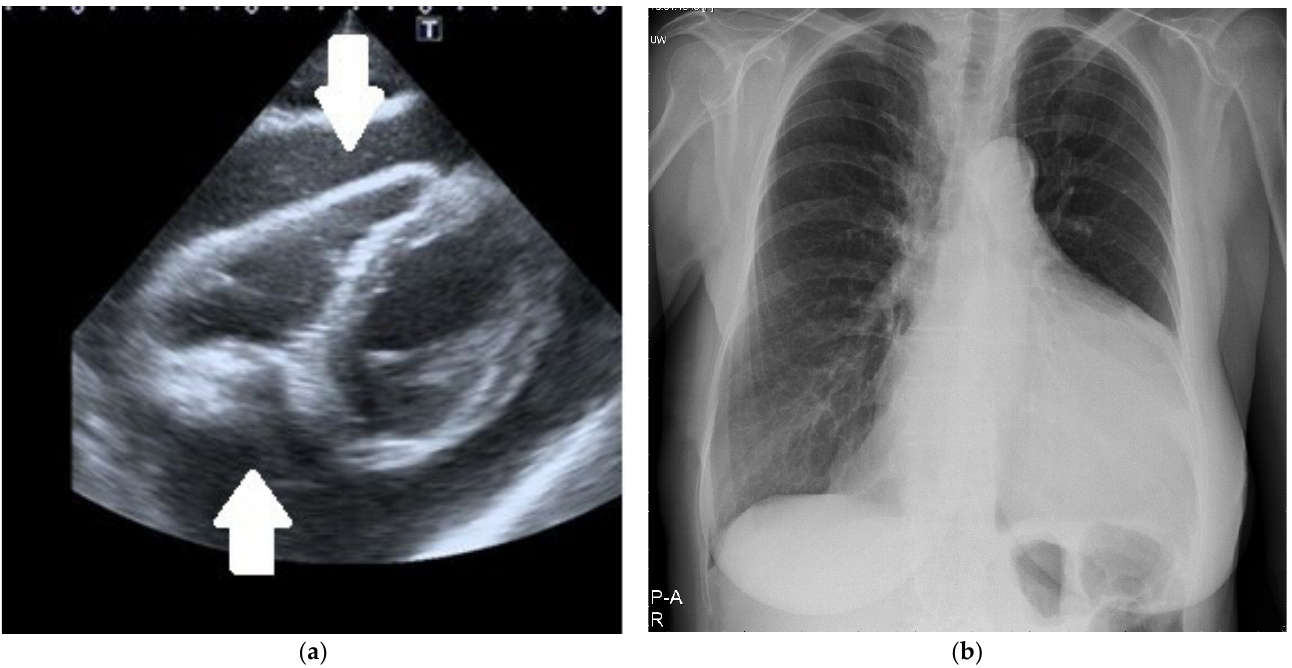
Figure 1. ( a ) Two-dimensional echocardiography. The subcostal intermediate off-axis view shows significant circumferential pericardial effusion (arrows). ( b ) Chest X-ray. Significant heart silhouette enlargement due to a large pericardial effusion.